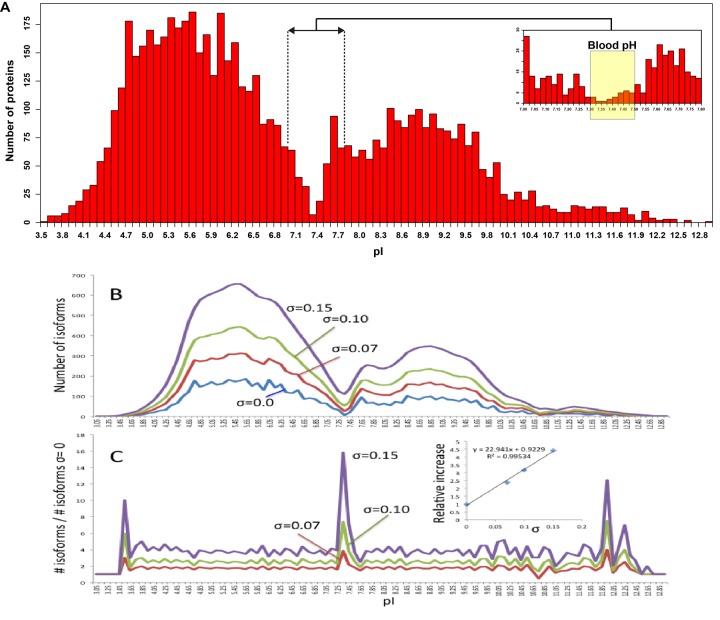
A. Theoretical pI distribution of 10,546 proteins in Plasma Proteome Database. B. The same as in A, assuming that every protein appears in a number of proteoforms with pIs distributed normally around the main proteoform with a standard deviation σ. C. The ratio between the plots in B and the plot at σ=0. Inset: increase in the number of proteoforms in the region of pI=7.4±0.05 compared to other pI regions as a function of σ.